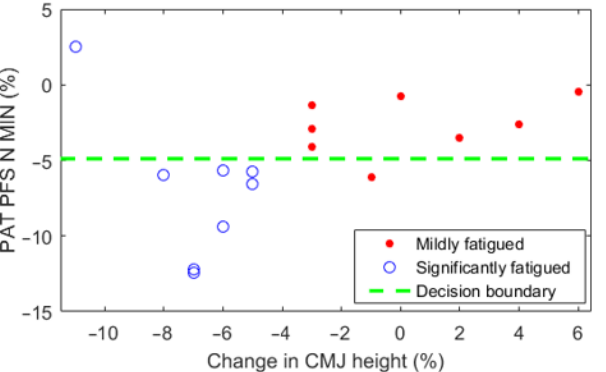
Figure 6. Change in CMJ height value compared to PAT_PFS_N_MIN value. The subjects were arranged into the mildly fatigued and significantly fatigued groups. The shown threshold is found based on the data from all the subjects.